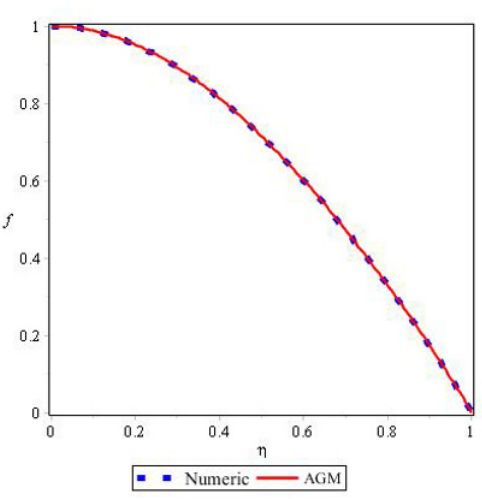
Figure 2. A comparison between the achieved solutions for f HPM and numerical method.